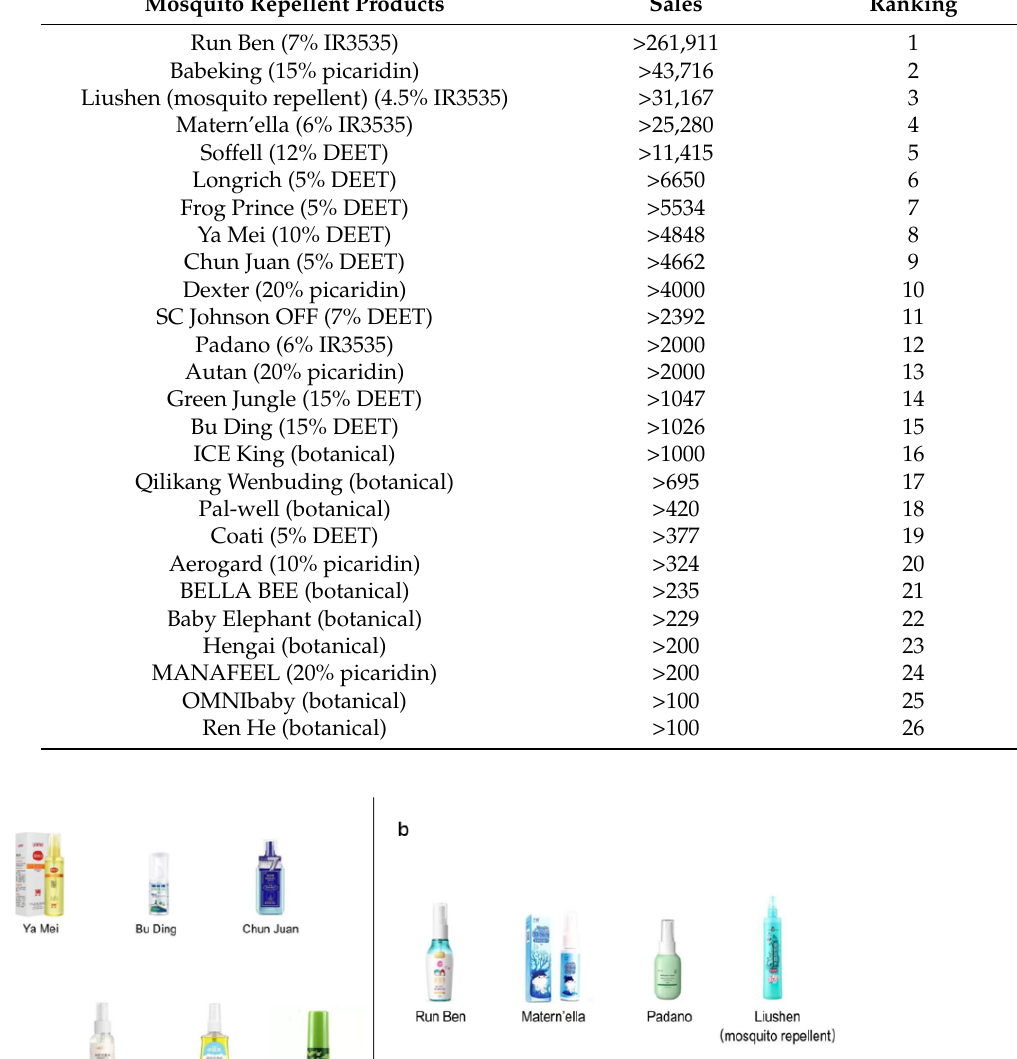
Table 1. Sales of various mosquito repellent products on e-commerce platforms Taobao and Jingdong in July.